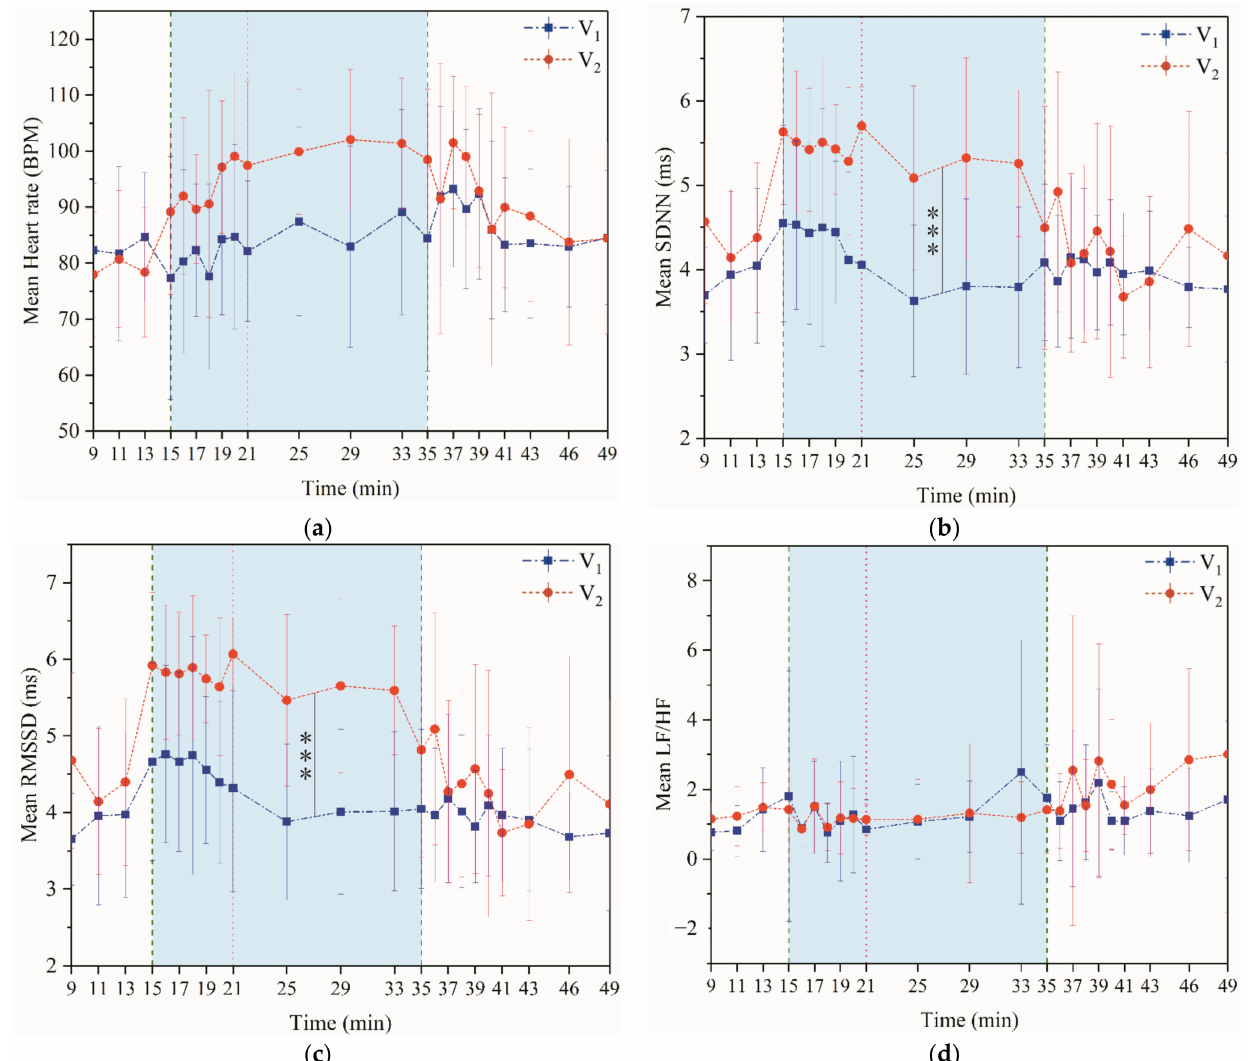
Figure 5. Multiple lines of mean HR and HRV (95% CI) by time and phase. ( a ) Mean heart rate ( b ) Mean SDNN ( c ) Mean RMSSD ( d ) Mean